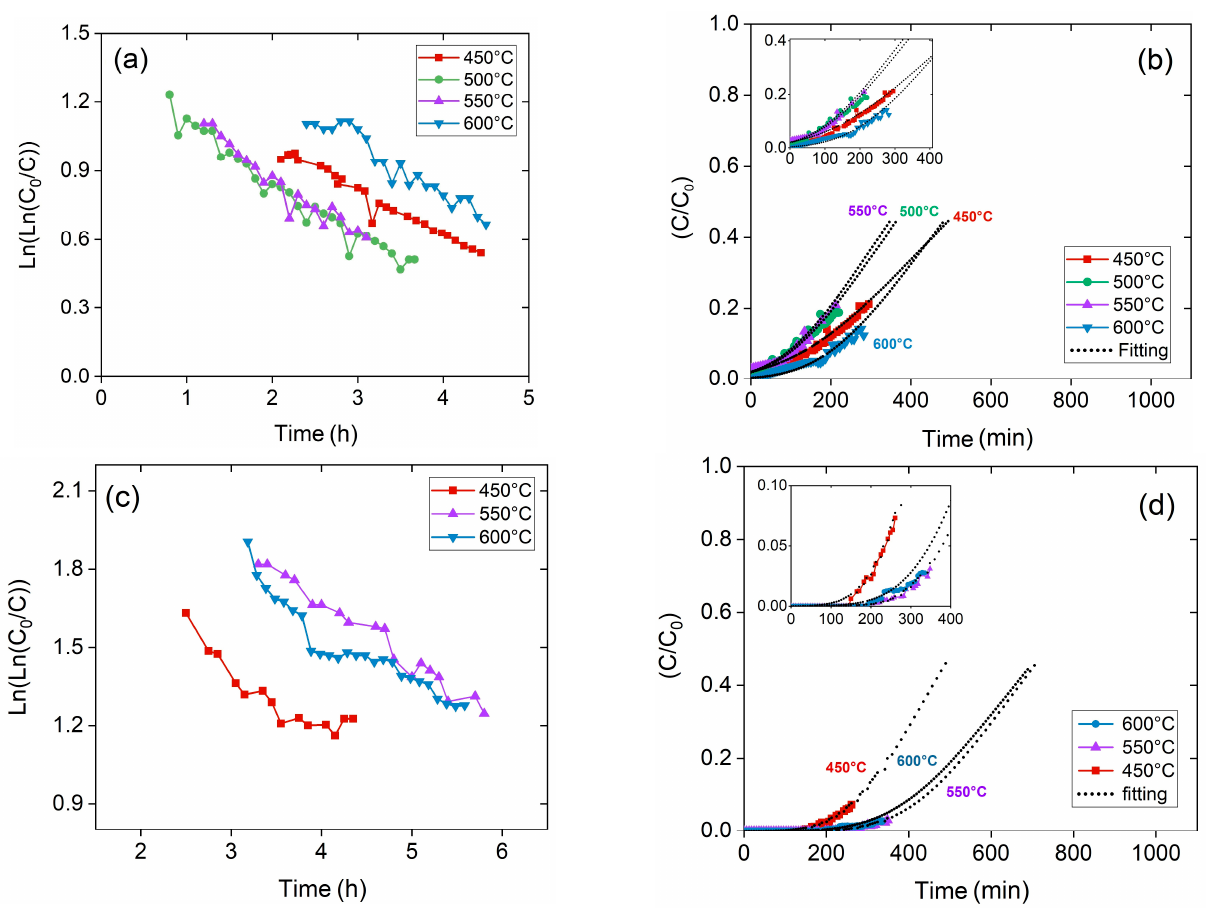
Figure 3. Outgoing H 2 S concentration vs. time plot at different temperatures (450, 500, 550, and 600 °C) considering a GHSV equal to ( a ) 50000 h − 1 and ( b ) 25000 h − 1 considering a gas flow of 305 NmL min − 1 .